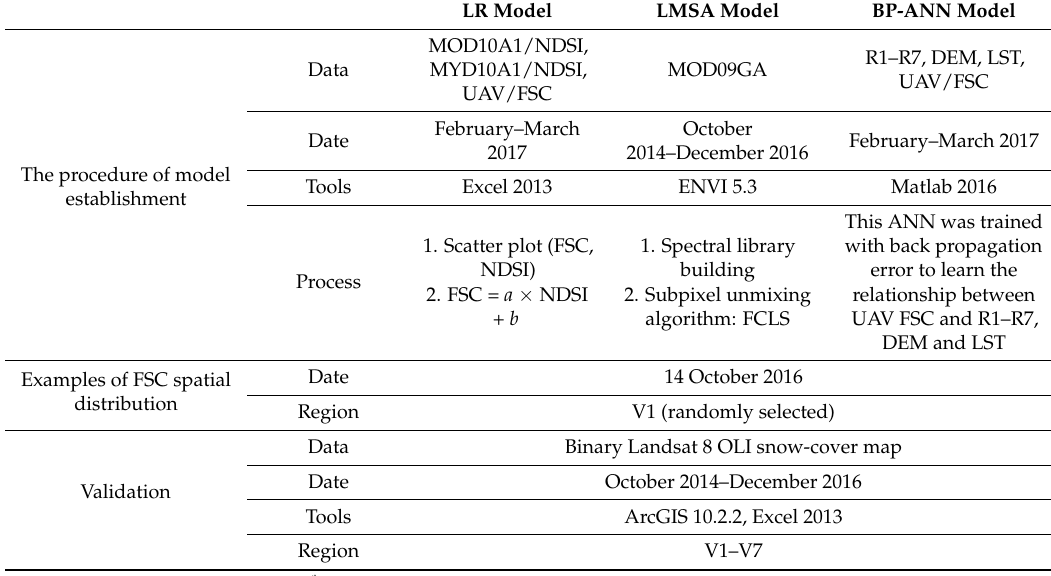
Table 3. The development processes of the LR, LMSA and BP-ANN models for the Tibetan